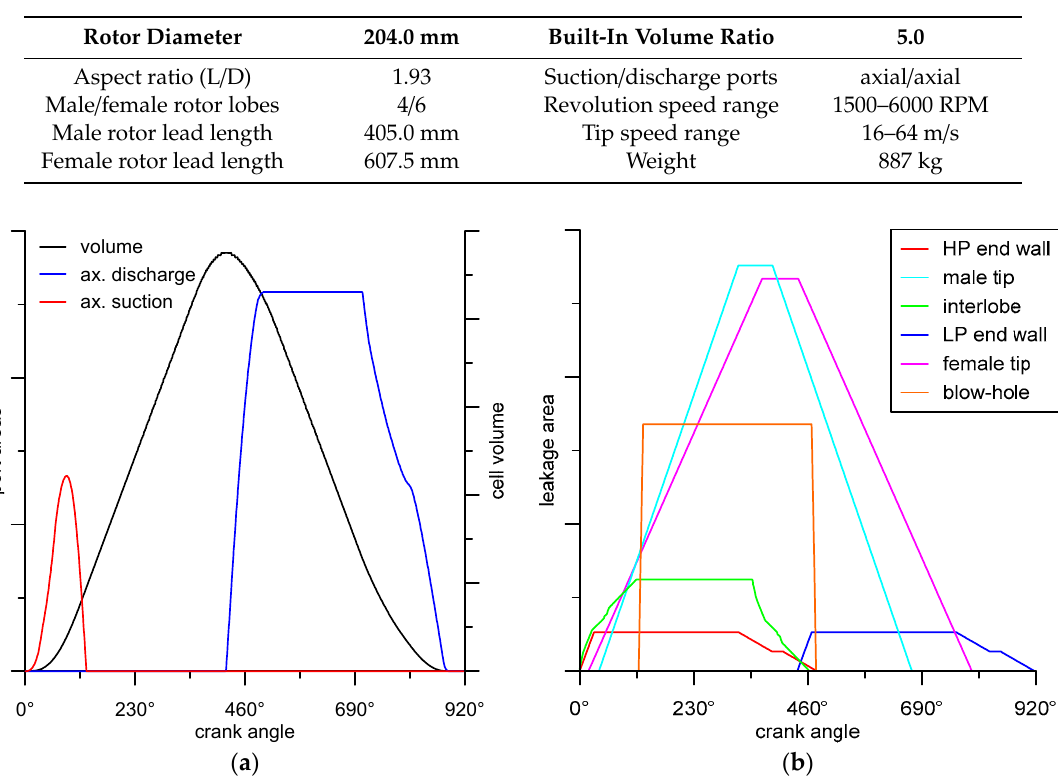
Figure 4. Geometrical input data for chamber modelling: ( a ) cell volume and ports areas; ( b ) leakage paths with reference to Figure 5 (courtesy of Howden Compressors Ltd.).